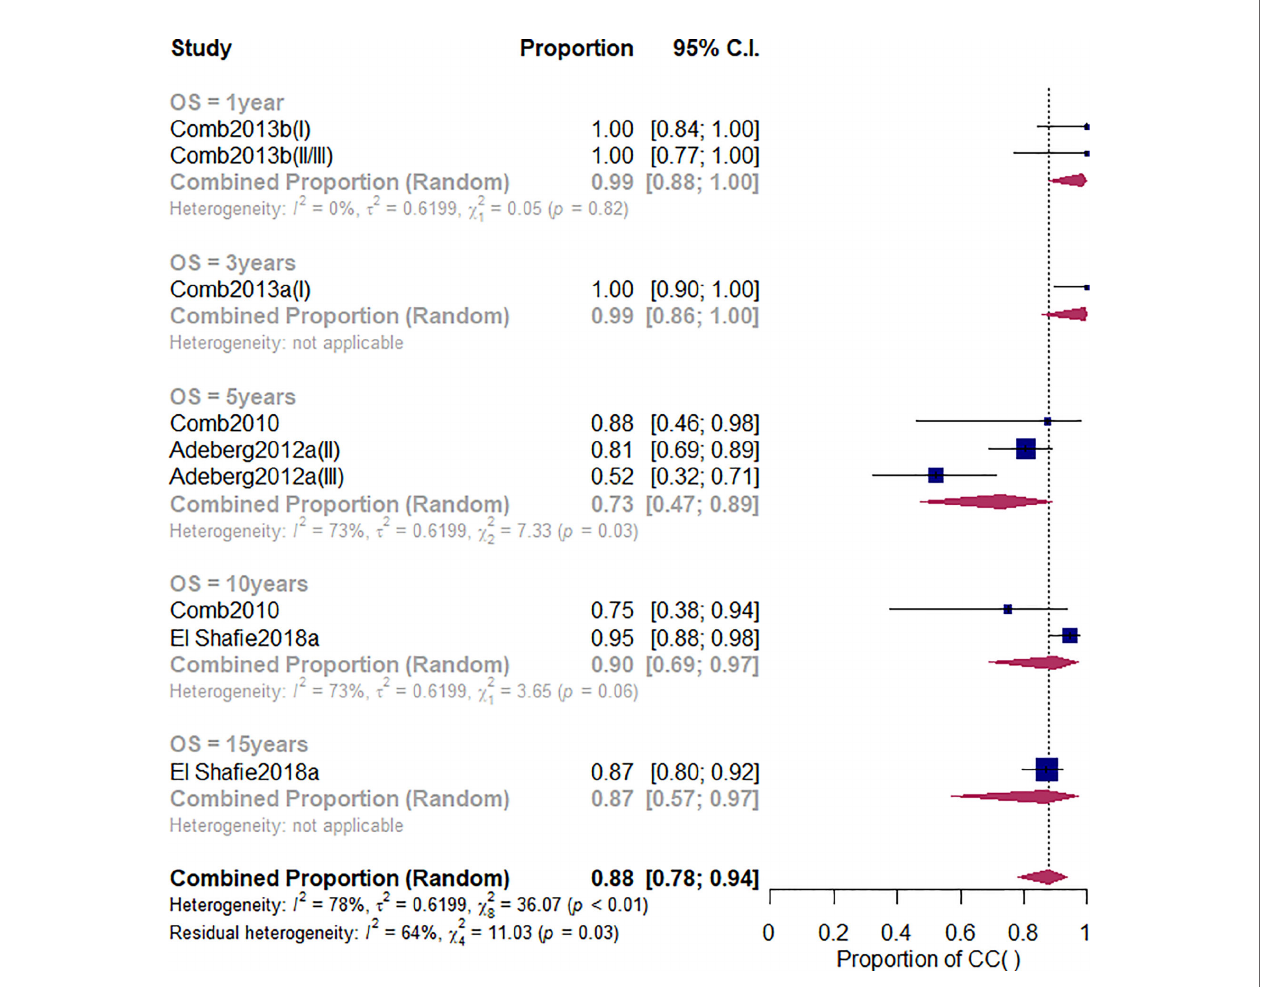
FIGURE 2 | The overall survival rate of meningioma initial diagnosis treated with